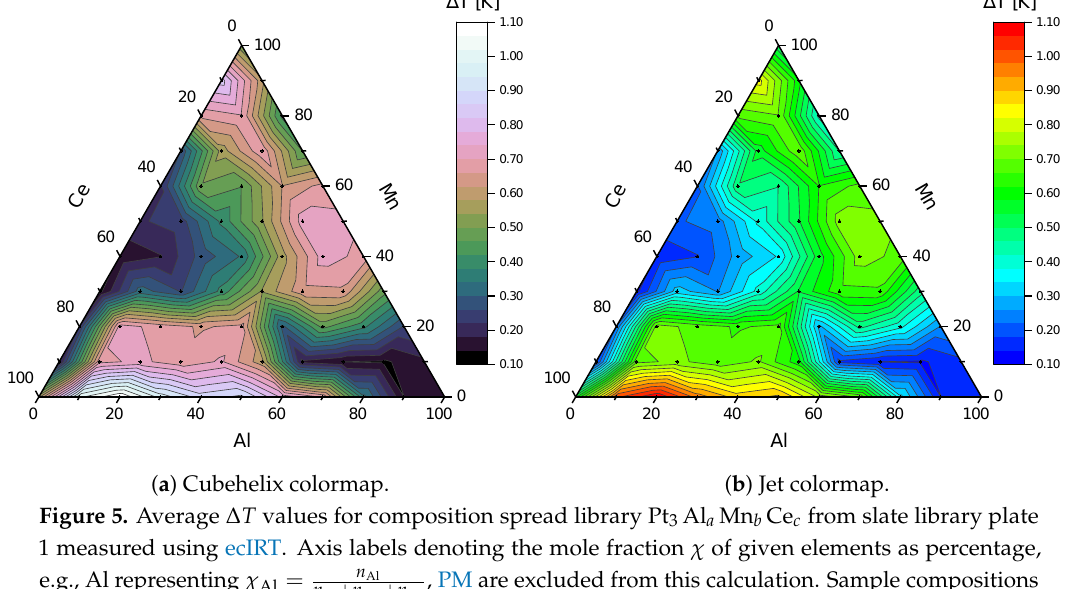
(a) Cubehelix colormap. (b) Jet colormap. Figure 5. Average ∆ T values for composition spread library Pt 3 Al a Mn b Ce c from slate library plate 1 measured using ecIRT. Axis labels denoting the mole fraction χ of given elements as percentage, e.g. Al representing χ Al = n Al n Al + n Mn + n Ce , PM are excluded from this calculation. Sample compositions displayed by a dot, values between dots are generated using linear interpolation. Table 1. Composition of most promising materials from composition spread library Pt 3 Al a Mn b Ce c on slate library plate 1, positions on slate library 1, and average ∆ T .